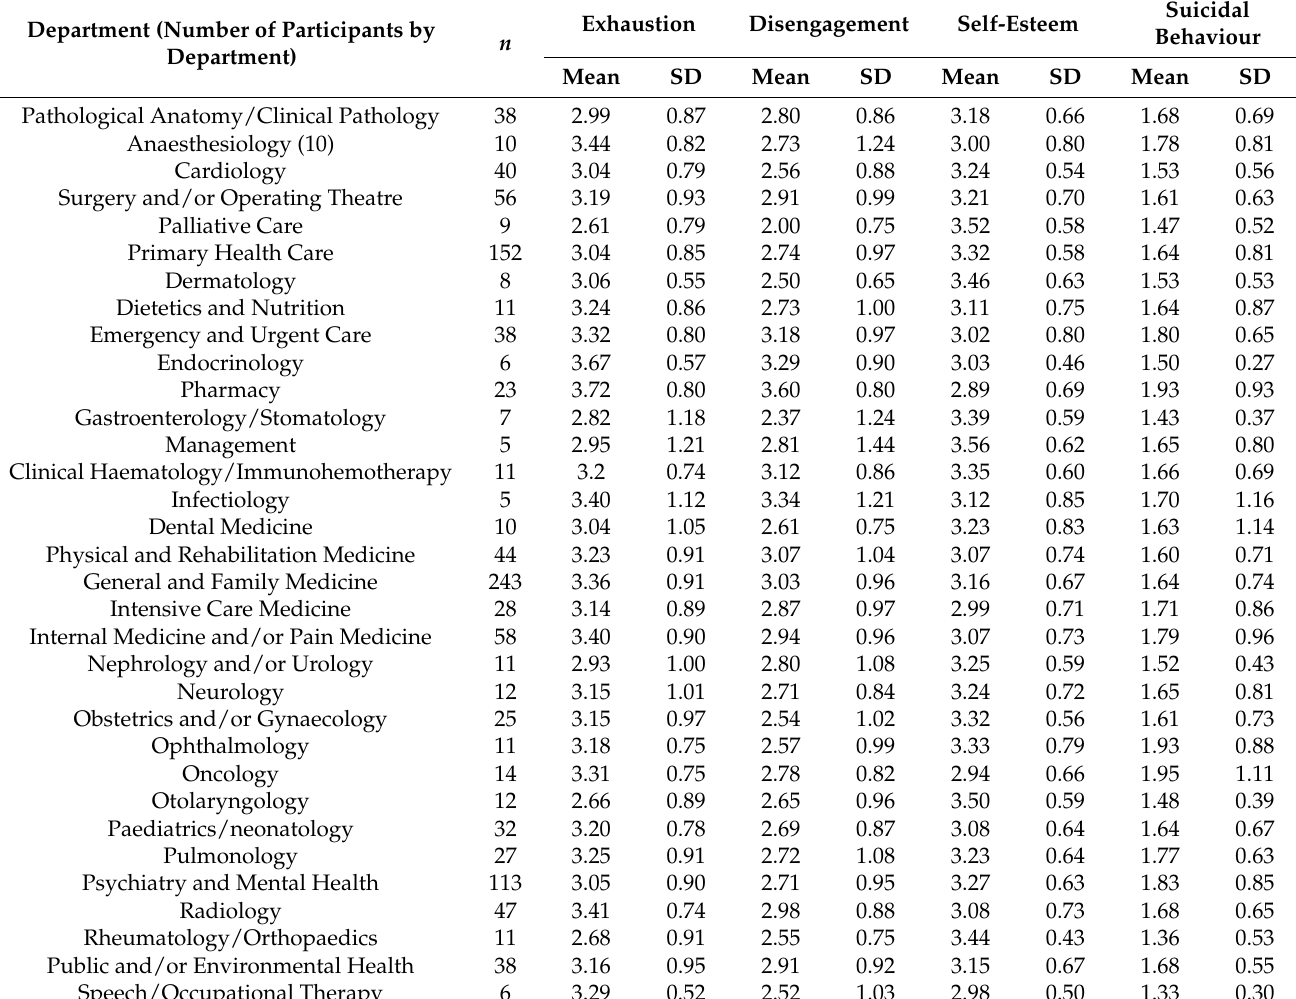
Table 2. Distribution of the variables under study according to activity